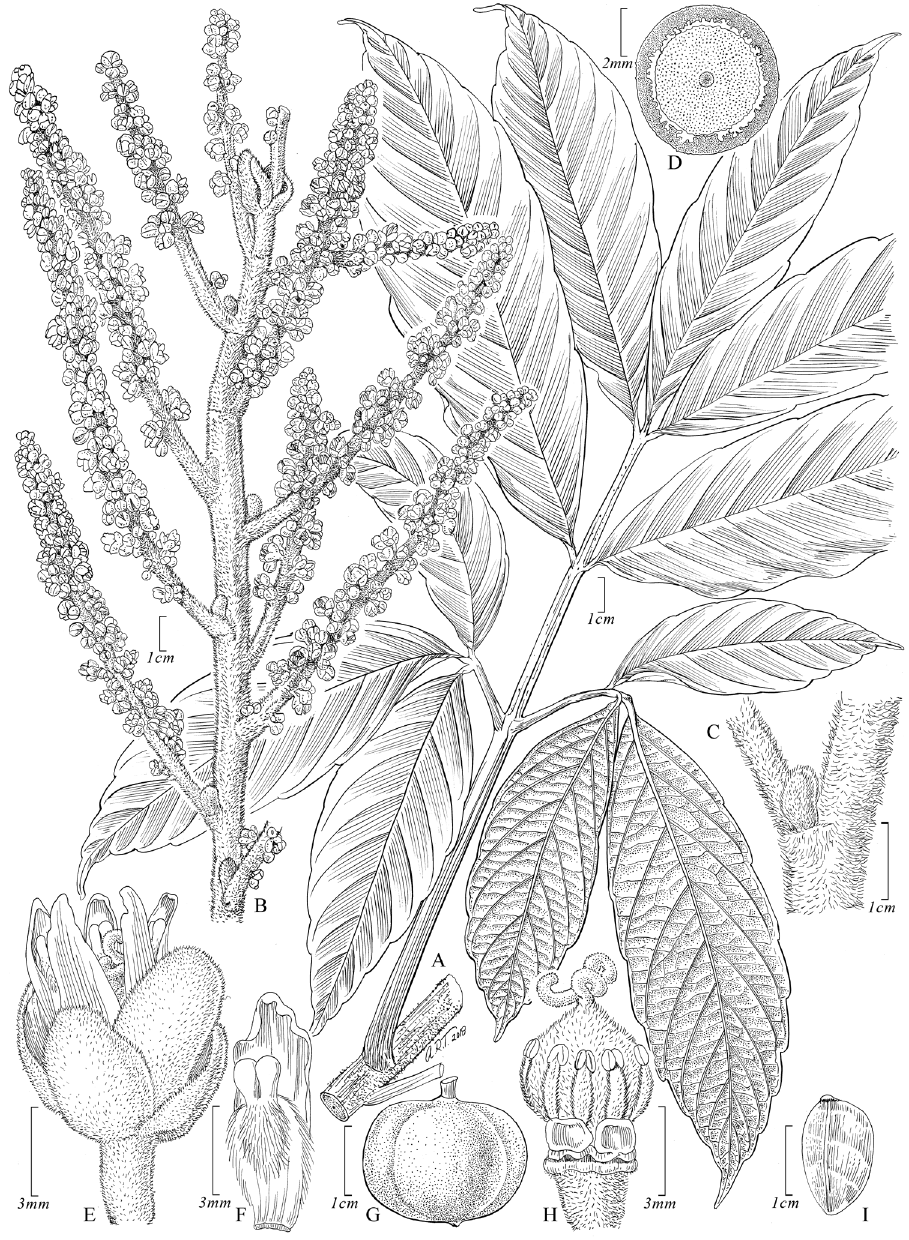
Figure 6. Paullinia wurdackii . A Leaf with stem fragment B Inflorescence C Bulbous, axillary bud D Cross section of stem E Pistillate flower, lateral view F Posterior petal with appendage, frontal view G Fruit H Flow- er with removed perianth showing nectary lobes, staminodes, and gynoecium I Seed, ventral view. A from Croat 58698 (MO) B–F, H from Acevedo-Rodríguez & Cedeño 7654 (US) G, I from Pitman 602